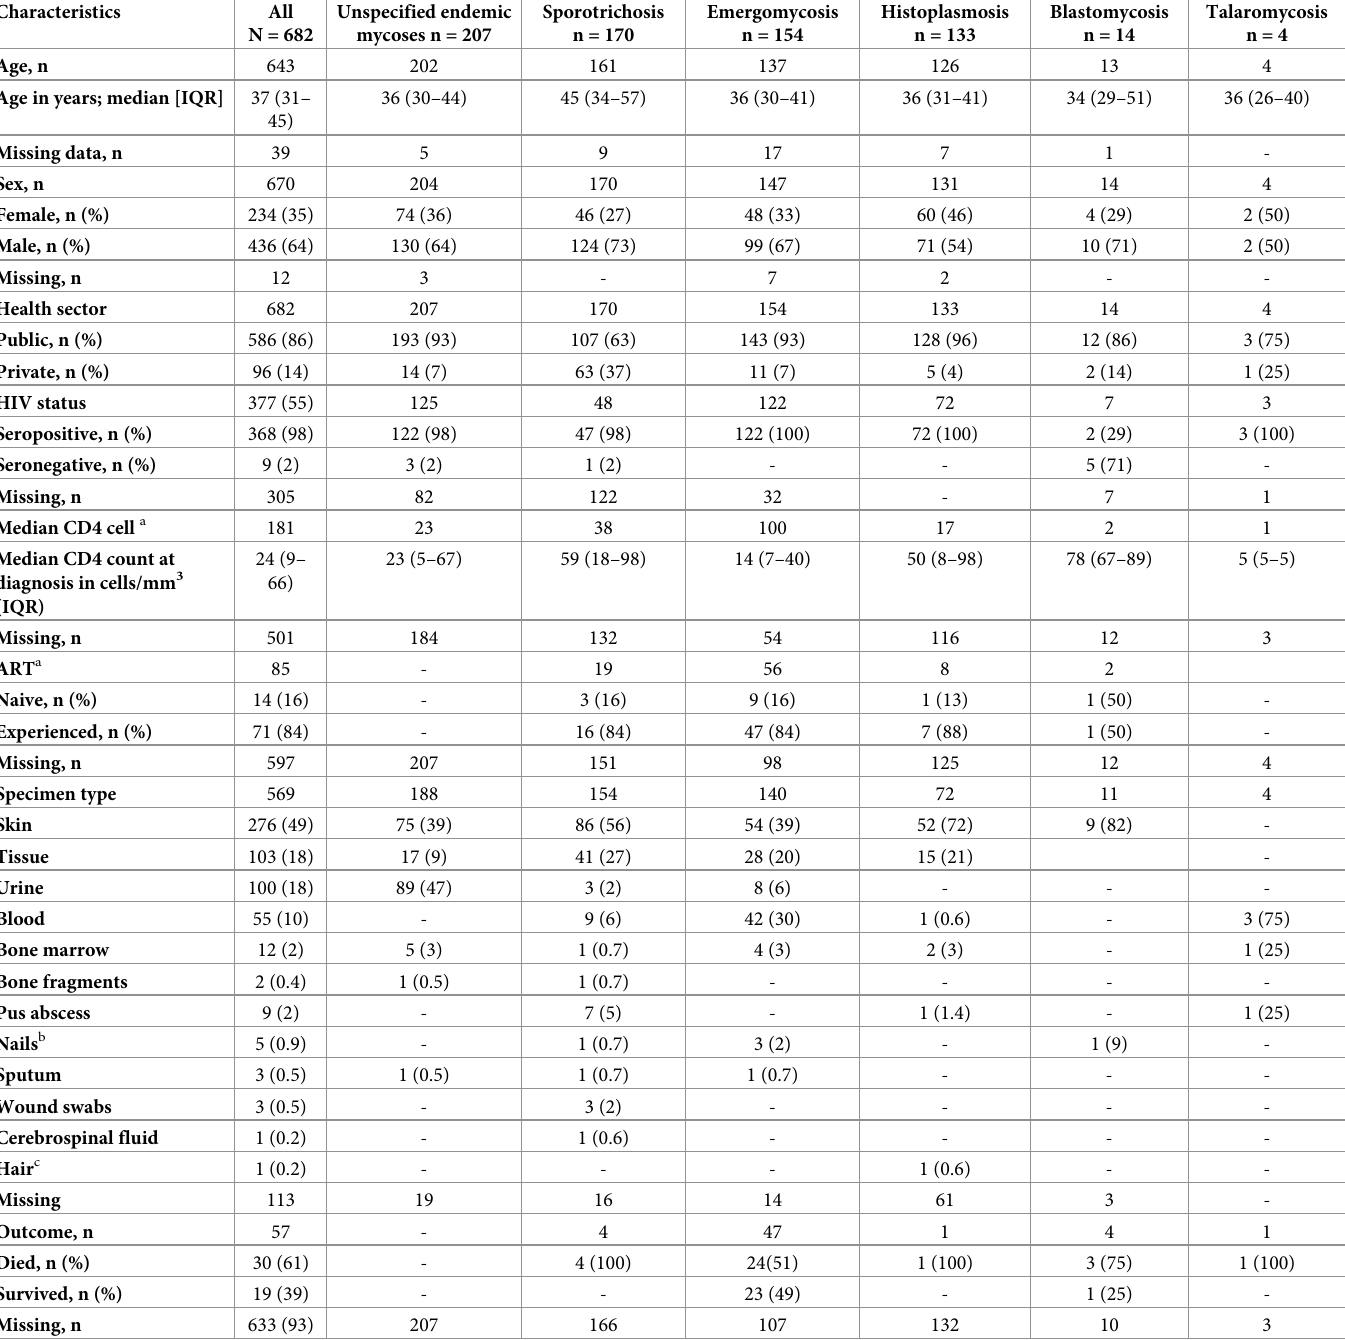
Table 1. Demographic and clinical characteristics of patients with proven, probable or possible laboratory-diagnosed endemic mycoses in South Africa (2010– 2020), n = 682.